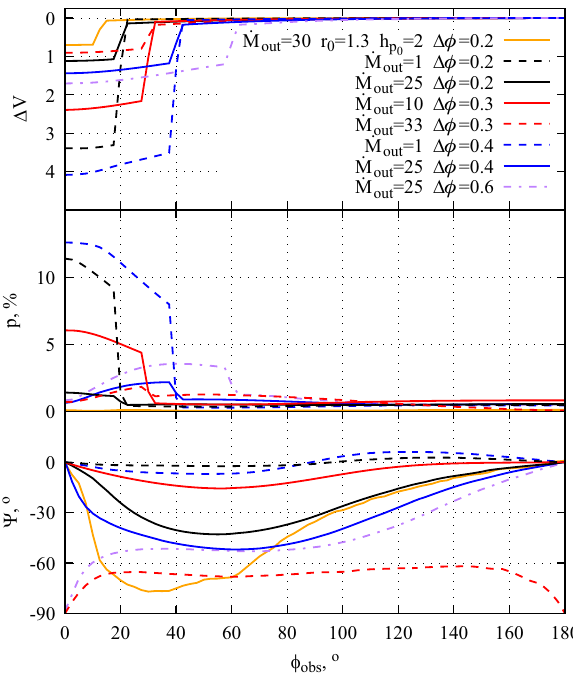
Figure 8: The same as in Figure 7 for various disk perturbations and mass out fl ow rates. The mass out fl ow rate is indicated in units of −9 per year. r 0 is measured in au. = r Δ 0.3 au for all models. ⊙ M 10 When h p and r 0 are not listed, they are 6 and 0.8 au 0